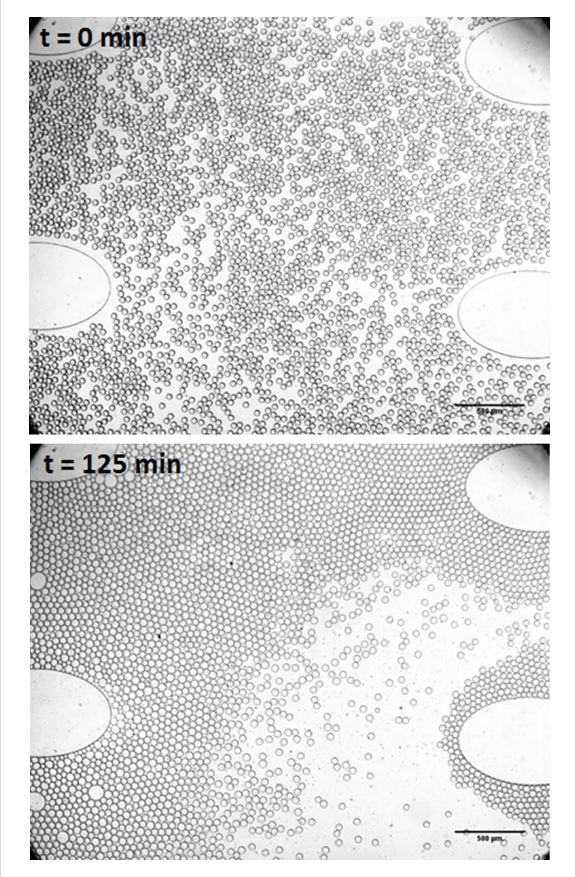
Figure 4: Osmotic exchange and coarsening of co-incubating aqueous microdroplets. 50 mM glycylglycine and pure H 2 O droplets were co-in- cubated in the same chamber. Upper panel: mixed but monodisperse droplet population at t = 0 min; lower panel: t = 125